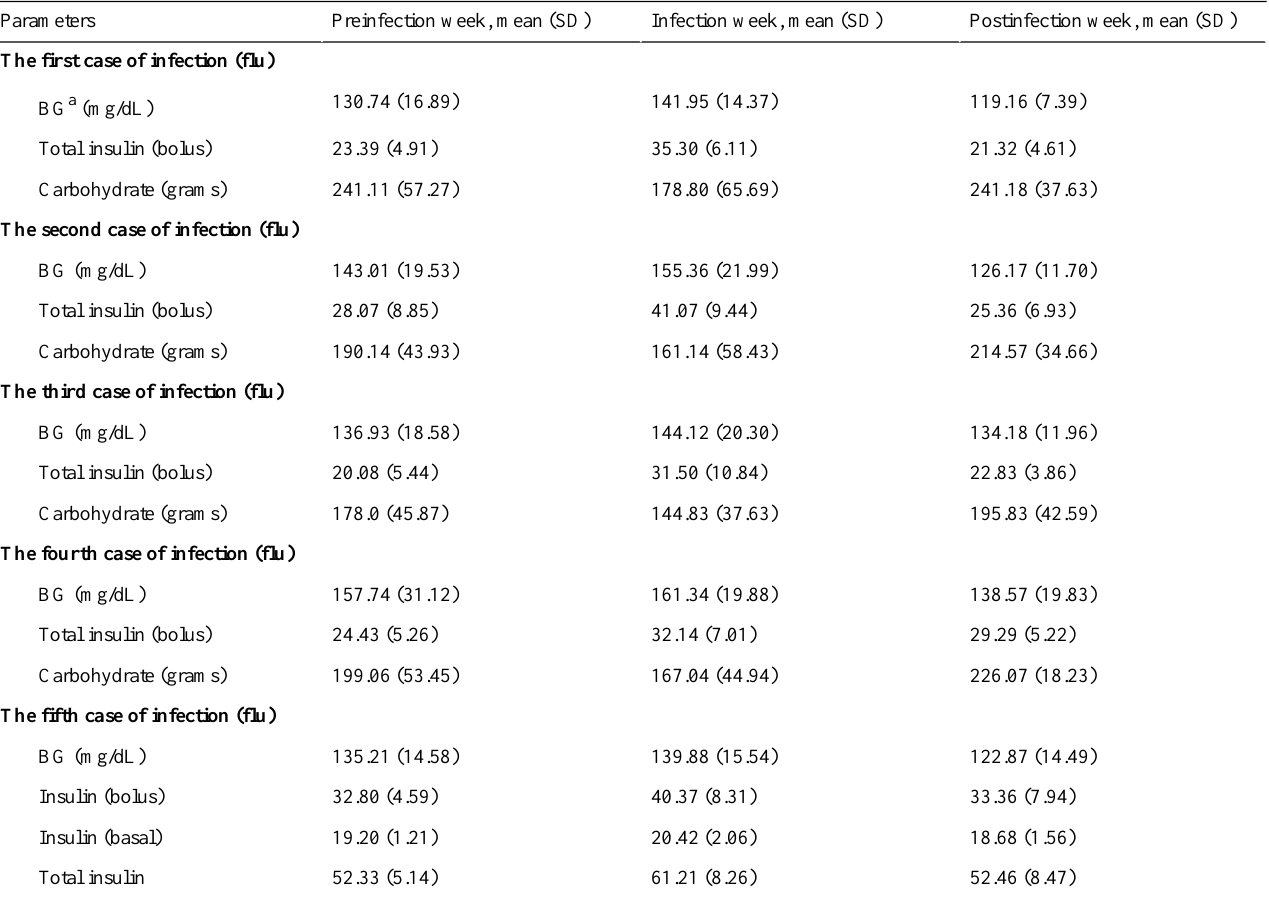
Table 5. Mean and standard deviation of blood glucose levels, total insulin (bolus), and total carbohydrate during the preinfection week, infection week, and postinfection